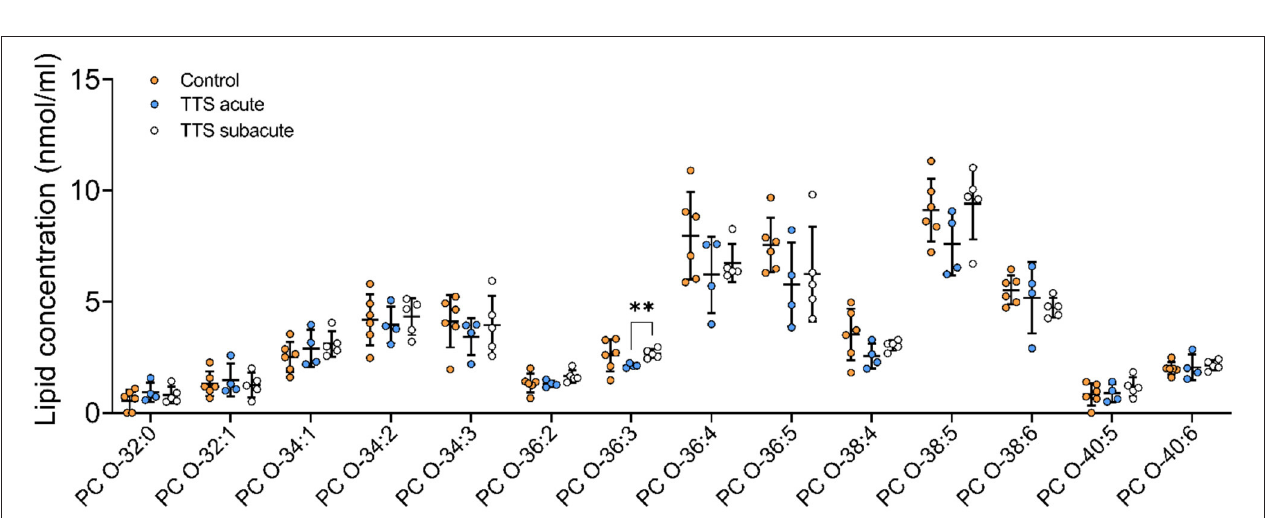
FIGURE 3 | Composition of individual PC O lipid species in the acute TTS, subacute TTS, and control groups. Values are represented as nmol/ml. Values are mean ± SD, P -value: ** P < 0.01. Where significance is not mentioned, values are considered as being not significant. PC O, Ether-phosphatidylcholine; TTS, Takotsubo